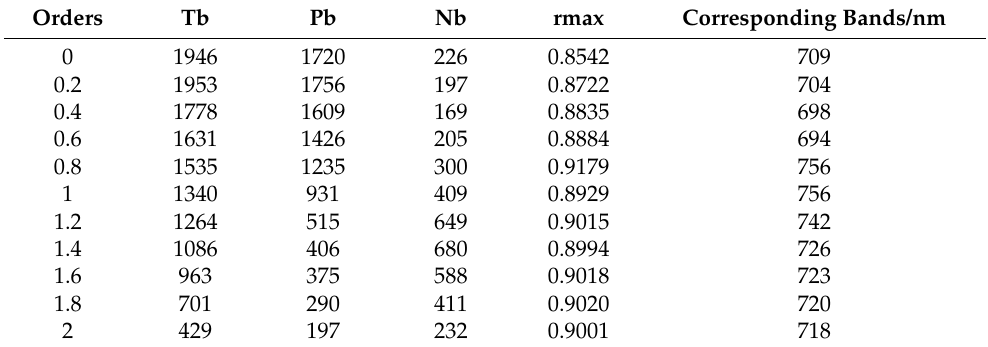
Table 2. Statistical table of the number of spectral bands passing the 0.01 significance test (0–2 order).